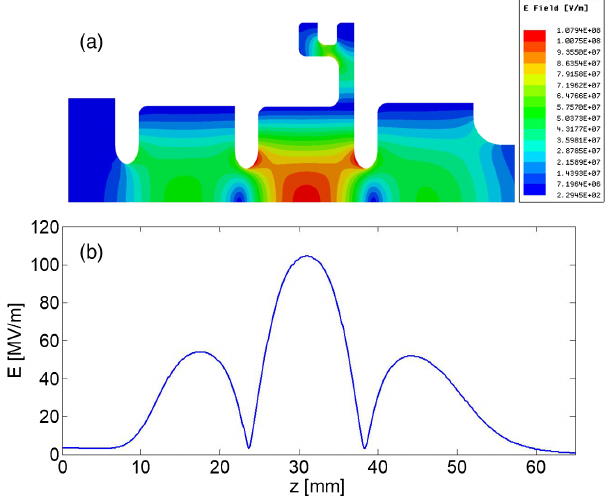
FIG. 4. Electrical field distribution of THU-CHK-#1 at input power of 1 MW. (a) Electrical field on the cross section.